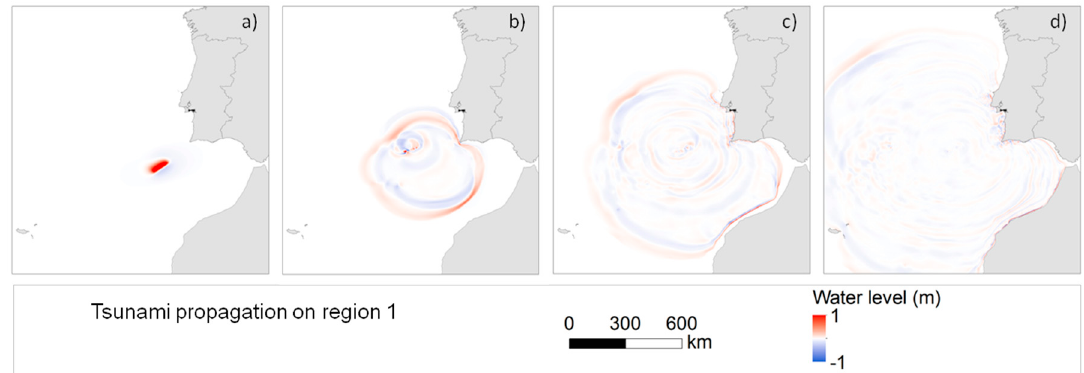
Figure 5. Tsunami propagation snapshots of computational region 1 for the 1969 Tsunami: ( a ) initial sea surface displacement; ( b ) 20 min; ( c ) 40 min; ( d ) 60 min.